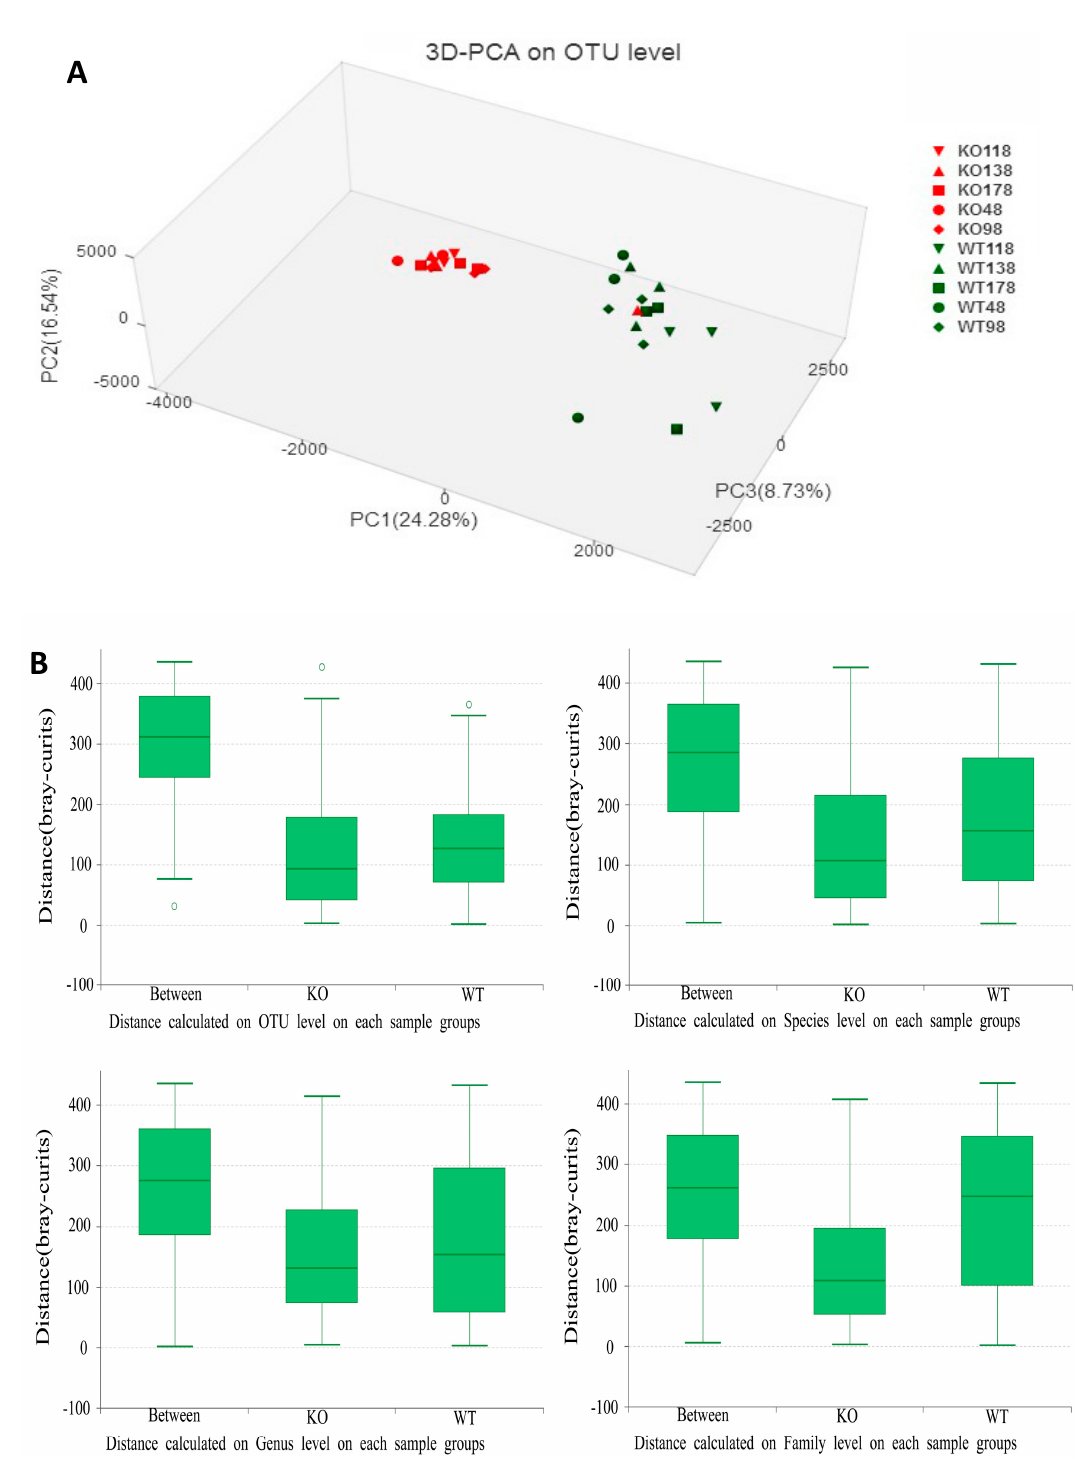
Figure 3. Principal components analysis (PCA) of 16S rRNA gene-sequencing analysis of gut microbes obtained from the Muc2 − / − and Muc2 +/+ mice. ( A ) PC1, PC2, and PC3 explain 24.28%, 16.54%, and 8.73% of variation, respectively. WT, Muc2 +/+ mice; KO, Muc2 − / − mice. The sample names represented the sampling time and genotypes, e.g., KO48 indicated the samples collected from Muc2 − / − mice at day 48, and WT48 indicated the samples collected from Muc2 +/+ mice mouse at day 48. OTU—operational taxonomic units. ( B ) Analysis of similarities (ANOSIM) at different categorical levels were conducted. The middle line in the group “between” were higher than in “KO” ( Muc2 − / − ) and “WT” ( Muc2 +/+ ) group, so the differences inter-treatment was bigger than that intra-treatment at family, genus, species and OTU levels in Muc2 − / − and +/+ mice. “0” meant the normalization